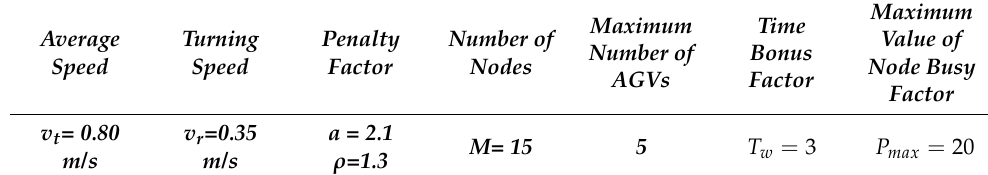
Table 5. Parameters of the GA-KL